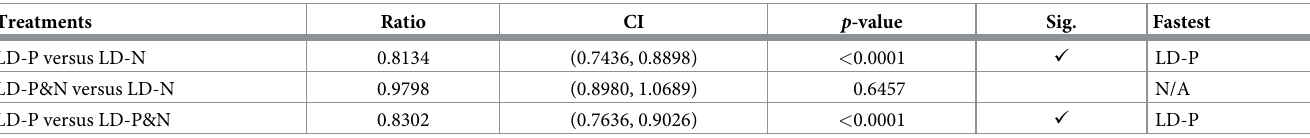
Table 10. LD : Overall time